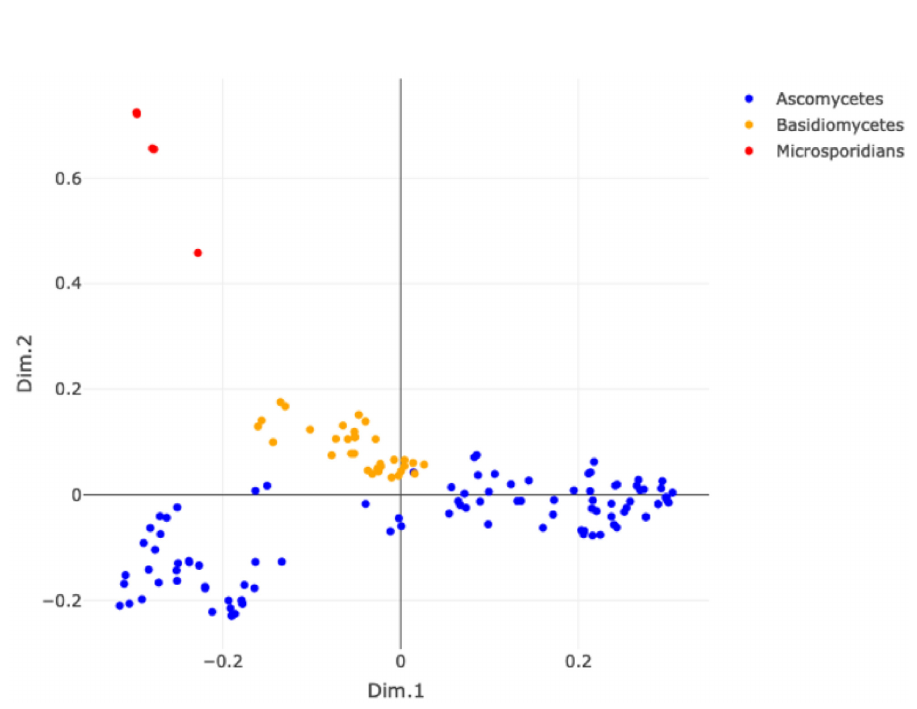
Fig 6. MDS plot of the WL similarity matrix of the KEGG Fungi (left) and composition of clusters w.r.t. a total of three clusters for the WL graph kernel.